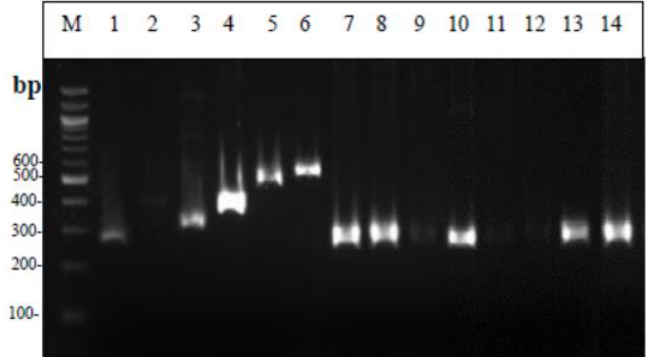
Figure 1. Results from Multiplex PCR. M: 100 bp DNA ladder, 1: Lacticaseibacillus subsp. paracasei ATCC 25302, 2: Lactococcus garvieae subsp. garvieae DSM 20684, 3: Lactobacillus pentosus NCFB